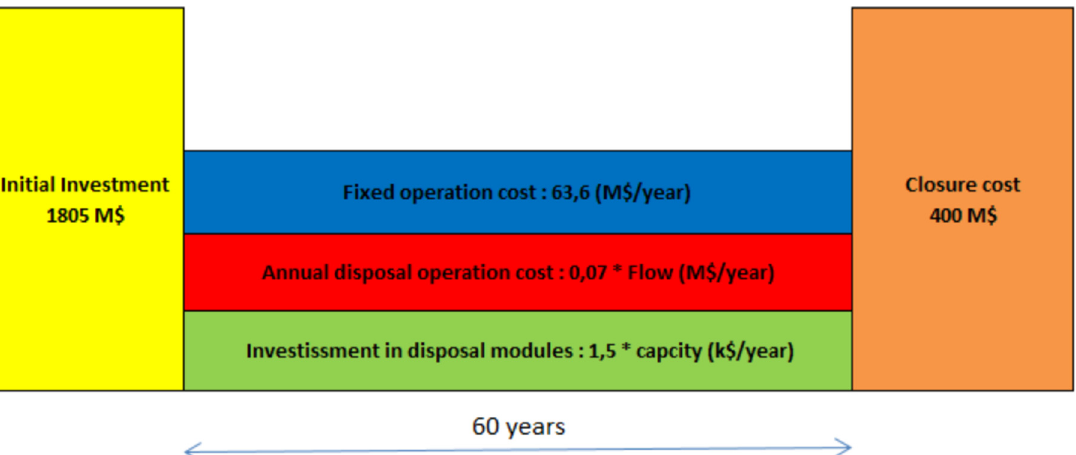
Fig. 6. Breakdown of disposal